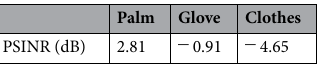
Table 4. TPG penetration